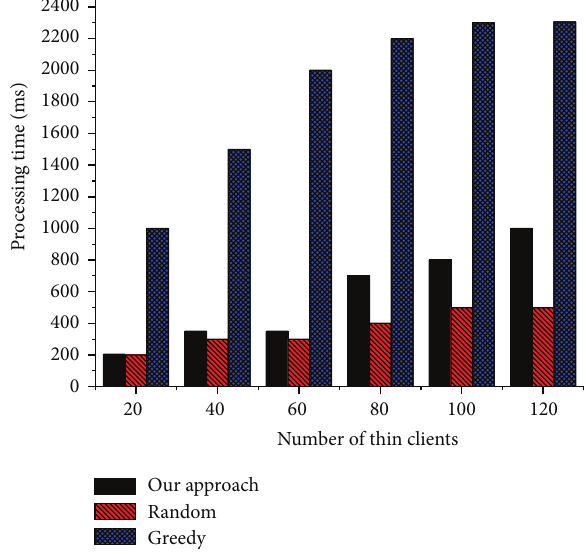
Figure 6: Execution time comparison with user